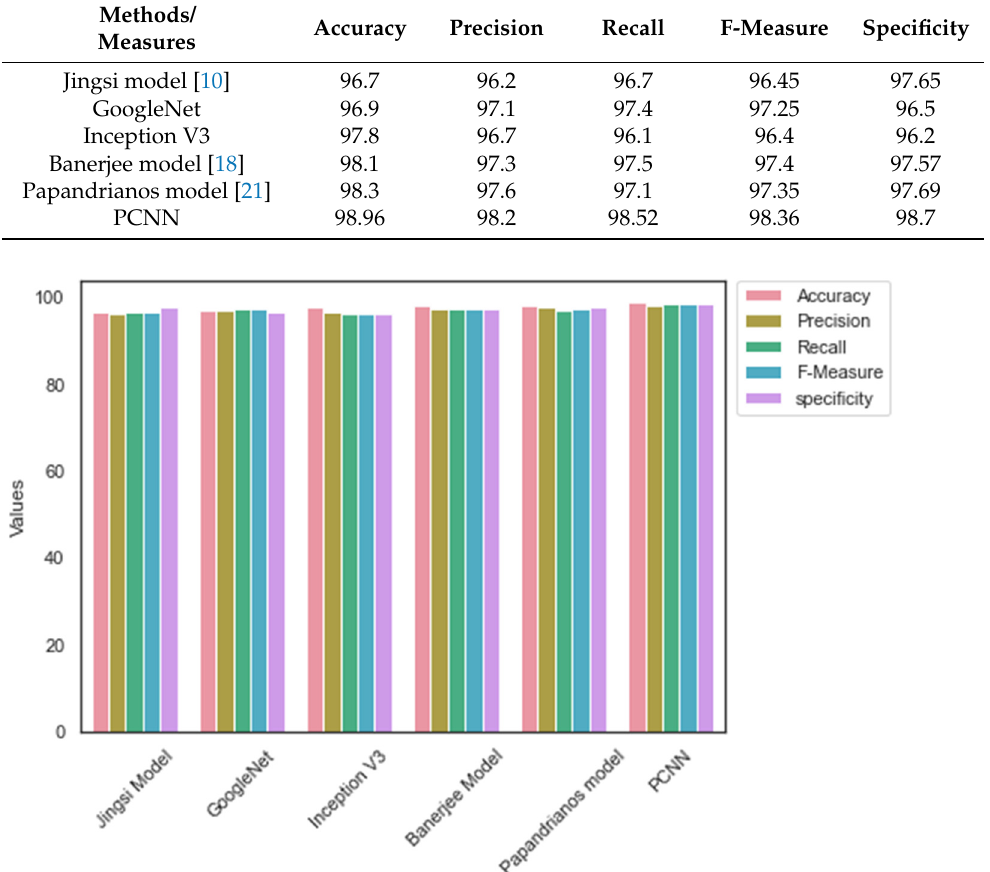
Table 8. Comparative analysis outcome of CNN model for dataset_2.